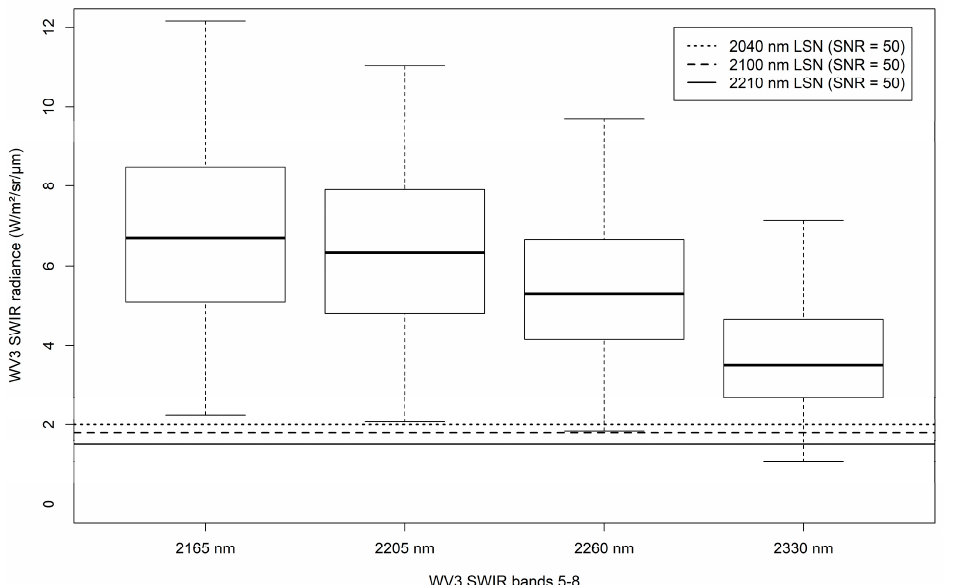
Figure 6. Observed WorldView-3 (WV3) shortwave infrared (SWIR) radiance under springtime conditions (boxplots) compared to simulated minimum radiance needed to achieve sensor signal-to-noise ratio (SNR) > 50 for Landsat Next (LSN) proposed bands at 2040 nm, 2100 nm, and 2210 nm (horizontal lines). SNR calculations for the ~2330 nm band were not included in Landsat Next radiometric simulations.